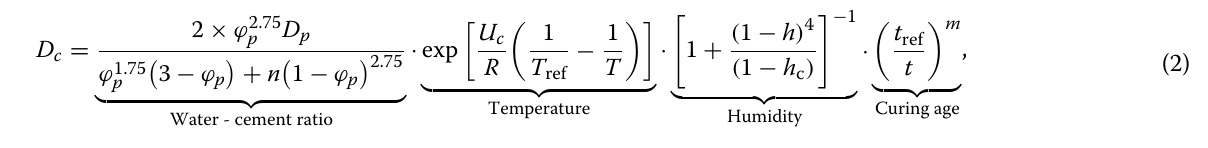
Fig. 1 that the surface chloride ion concentration ranges